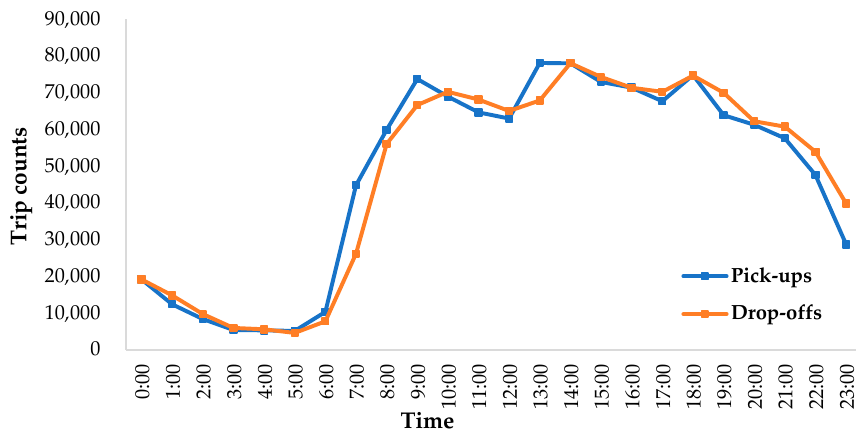
Figure 4. Hourly variation in ridership of ride-hailing on weekdays.